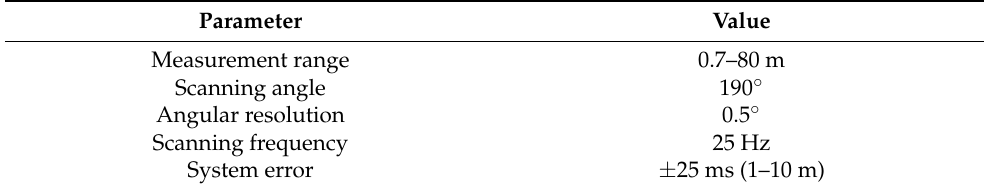
Table 2. SICK LMS511 parameters.